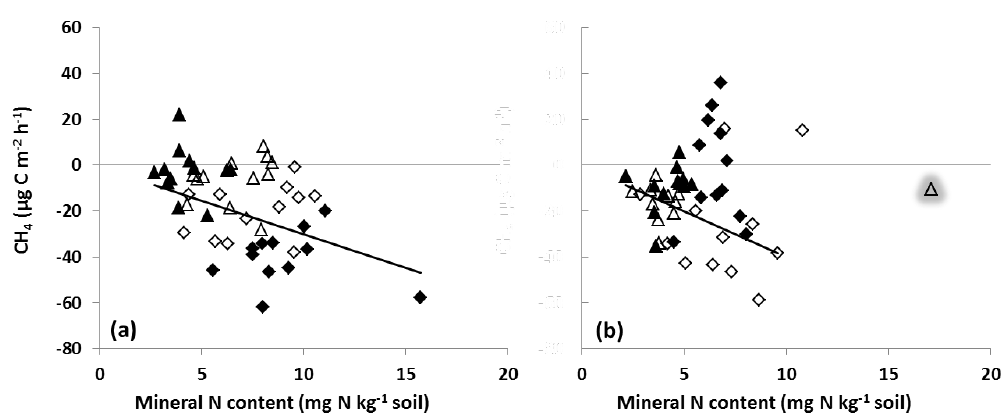
Figure 3. Relationship between soil CH 4 uptake and soil mineral N content, using the monthly-measurement means of four replicate plots per land-use type between December 2012 and December 2013: forest ( (cid:7) ), jungle rubber ( ♦ ), rubber ( (cid:78) ) and oil palm ( (cid:77) ) on the clay Acrisol soil (Pearson correlation: R =− 0.47, P = 0.01, n = 41) ( a ) and the loam Acrisol soil (Pearson correlation: R =− 0.52, P < 0.01, n = 38) ( b ). Correlations exclude net CH 4 emissions (fluxes above 0) in both landscapes and an outlier plot of oil palm on the loam Acrisol soil (shaded